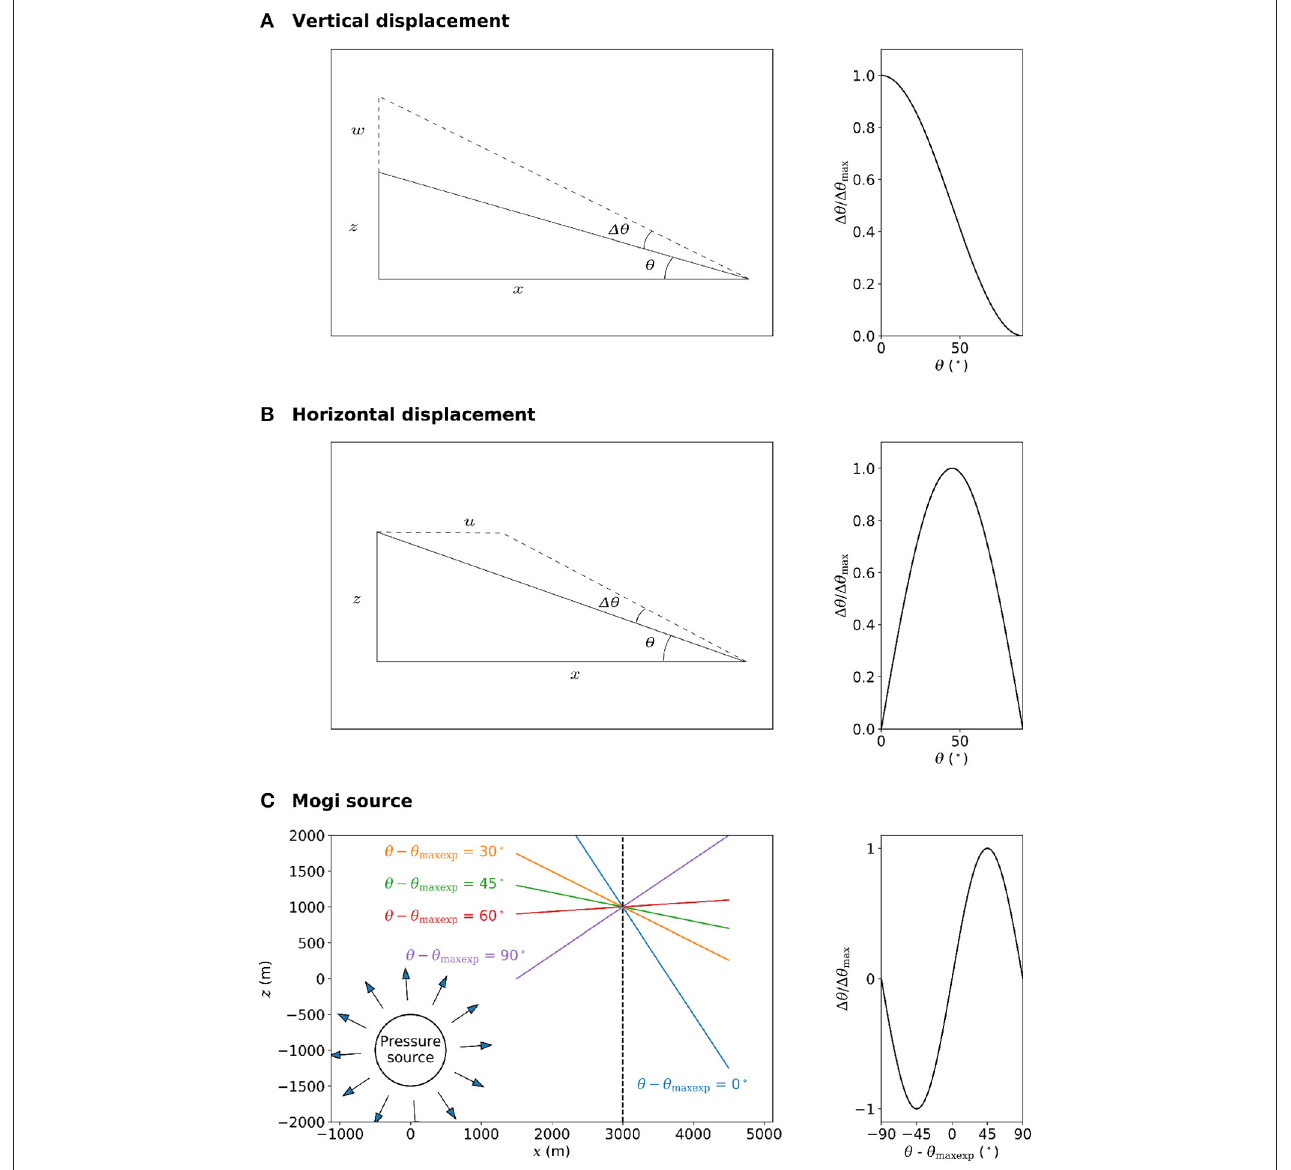
FIGURE 1 | Tilt produced by purely vertical (A) or horizontal (B) displacement that decreases linearly with distance from the conduit, as a function of the original angle of the slope θ . (C) : Tilt induced by a spherical source, as a function of slope angle, where θ − θ maxexp = 0 when the slope is perpendicular to the displacement